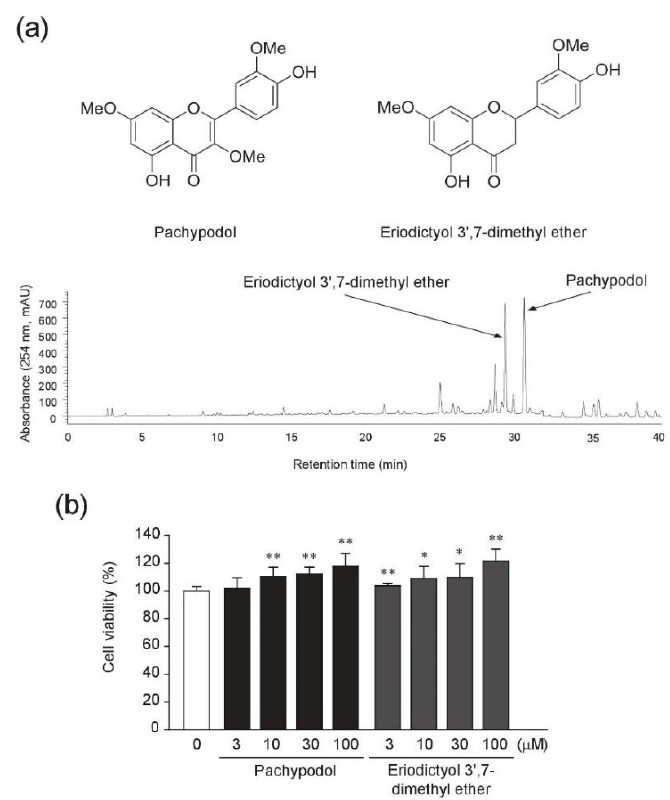
Figure 1. Chemical structure and cytotoxicity of pachypodol and eriodictyol 3',7-dimethyl ether in HepG2 cells. ( a ) Chemical structures and an HPLC chromatogram of the crude methanol extract from the dried leaves of Pogostemon cablin Bentham; ( b ) HepG2 cells were exposed to each compound (3–100 µ M) for 24 h after overnight serum starvation and the cell viability was measured by an MTT colorimetric assay. Data represent the mean ± S.D. ( n = 8). * p < 0.05, ** p < 0.01 (compared with the dimethyl sulfoxide (DMSO)-treated vehicle control); MTT, 3-(4,5-dimethylthiazol-2-yl)-2,5-diphenyltetrazolium bromide.